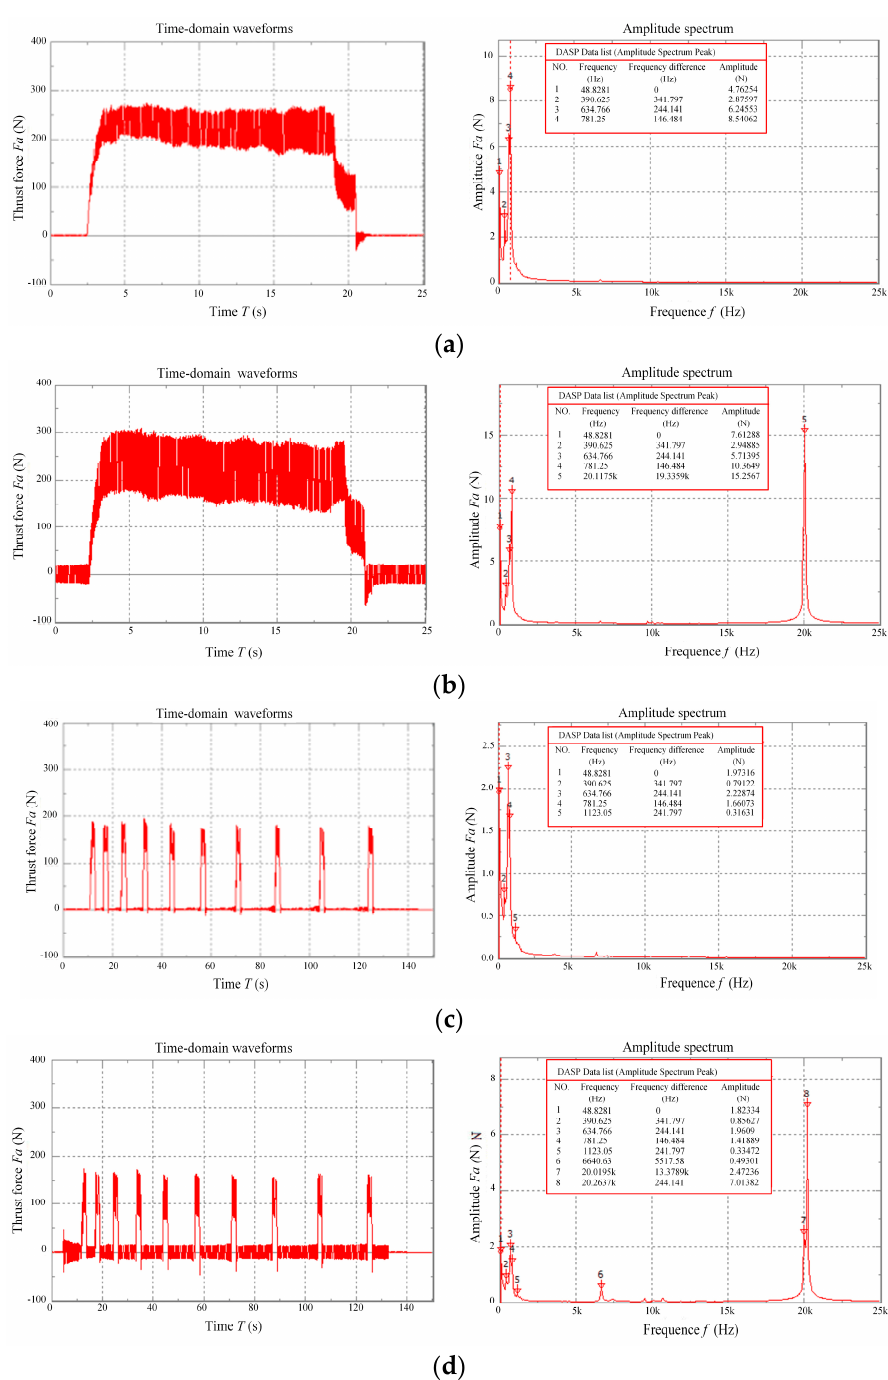
Figure 3. Time-domain waveforms and frequency spectrums of thrust force under different drilling techniques ( n = 1200 r/min, v f = 36 mm/min). ( a ) DD; ( b ) UVD ( f = 20 KHz, A = 2.2 μ m); ( c ) PD ( Q = 1 mm); and ( d ) UVPD ( f = 20 KHz, A = 2.2 μ m, Q = 1 mm).